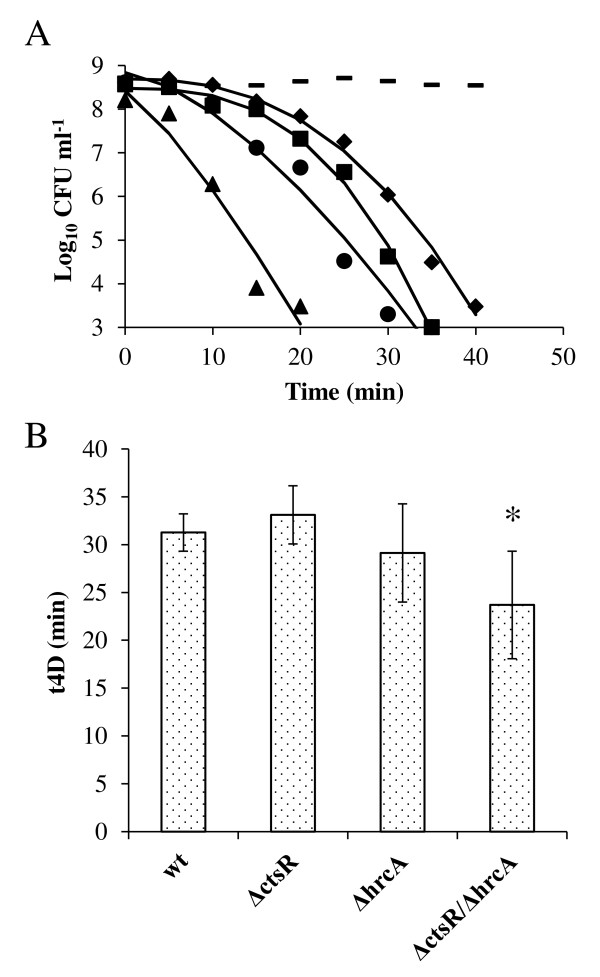
Involvement of CtsR and HrcA in hydrogen peroxide resistance. A) Colony forming units of L. plantarum WCFS1 (wt, squares), NZ3410 (ΔctsR, diamonds), NZ3425CM (ΔhrcA, circles), and NZ3423CM (ΔctsRΔhrcA, triangles) cultures when subjected to 40 mM H2O2 exposure. As a control, the ΔctsRΔhrcA strain was taken for incubation in PBS without H2O2 (dashes). Lines indicate the fitted reparameterized Weibull model data. Data shown are representative for 3 independent experiments. B) Time to the first 4 log10 reductions (t4D) for the same strains as in panel A. The t4D-value is the parameter estimate obtained by fitting a reparameterized Weibull model through the data and average for the 4 experiments. Error bars represent the 95% confidence interval of the parameter estimate. Significant difference from the wt (p < 0.05) is indicated by *.